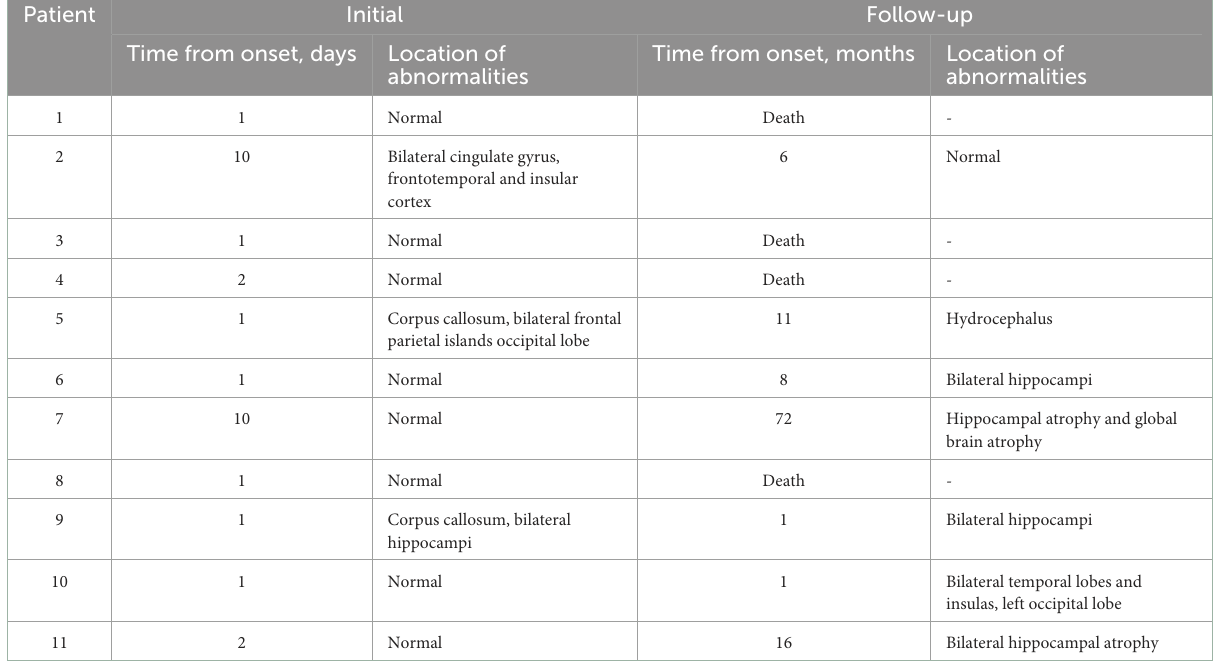
TABLE 3 The initial and follow-up brain